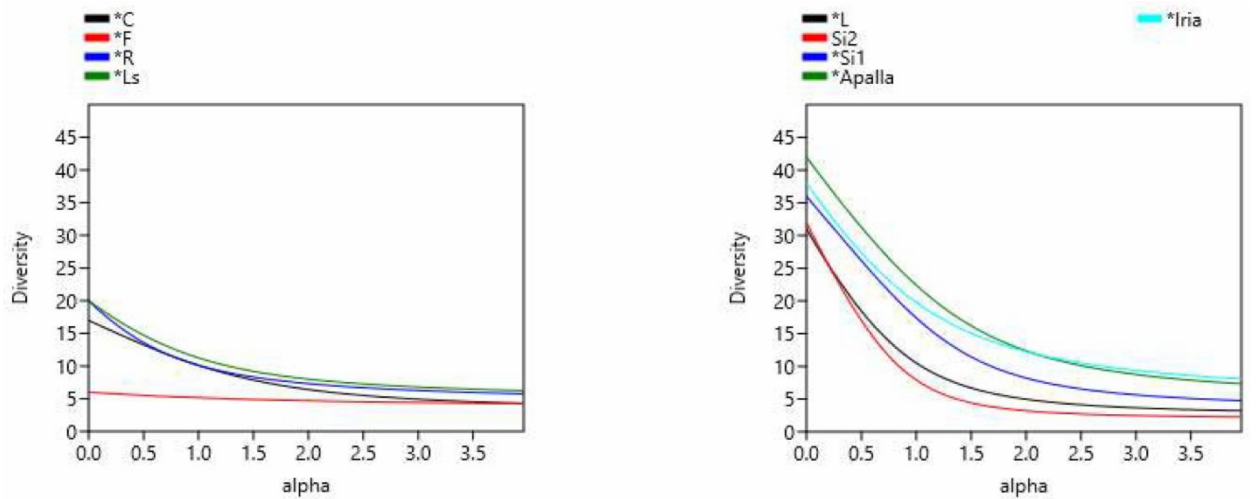
Figure 4. Diversity profiles for the community diversity of birds in buffer zone’s sites ( left ) vs. Nimule National Park ( right ), South Sudan. X-axis indicate the q-order of alpha-diversity (see Methods for